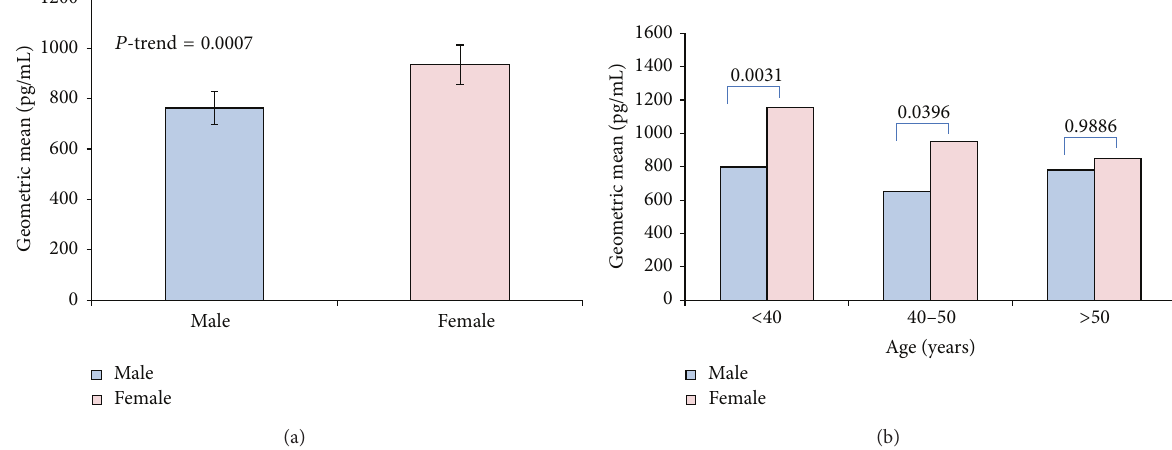
Figure 1: Ghrelin level in male and female Arab subjects. (a) Difference in plasma level of ghrelin in female and male Arab subjects reported as least square values adjusted for age and BMI. (b) Age distribution of plasma level ghrelin adjusted for BMI between male and female subjects. Generally, younger females less than 40 years old had the highest ghrelin level, which was decreasing with age.